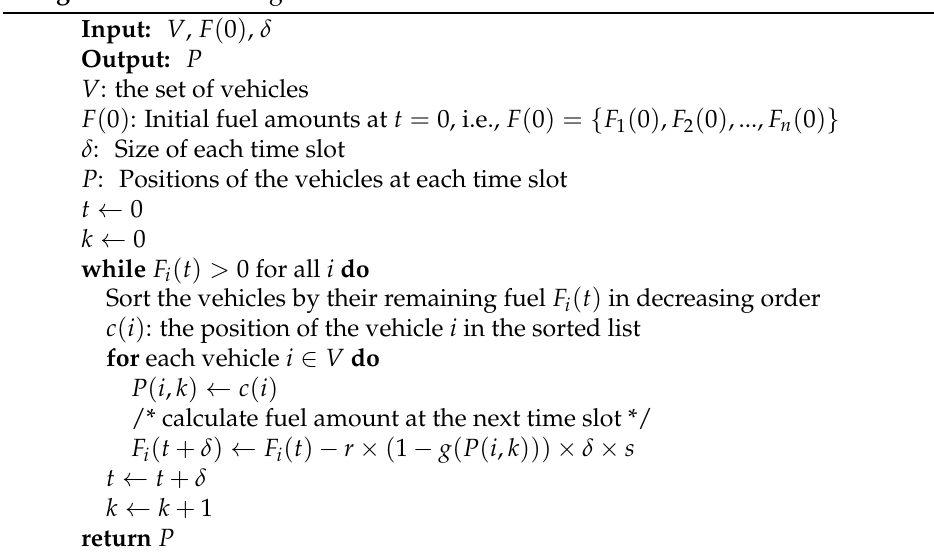
Algorithm 1: Traveling Time